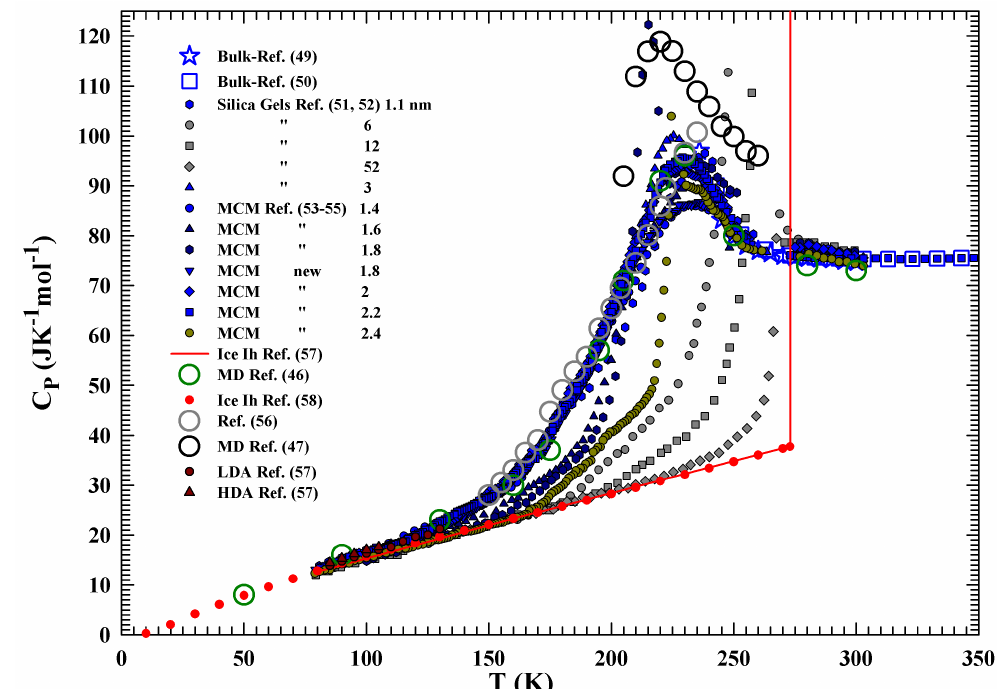
Figure 1. The C P ( T ) data measured, at the ambient pressure, in bulk[49,50], confined water [51–56] and those obtained by the two mentioned MD simulation studies [46,47]. Specifically, the bulk water data cover the range 236 < T < 350 K (thus including the supercooled regime), wheras confined water data are measured under different confining materials with various pores in the range 80 < T < 300 K.